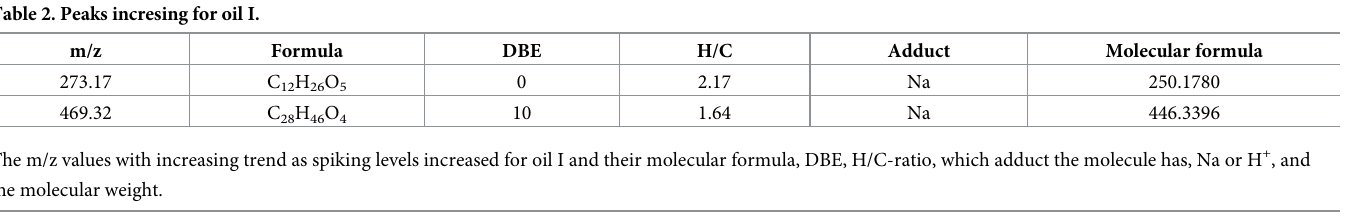
the molecular weight.